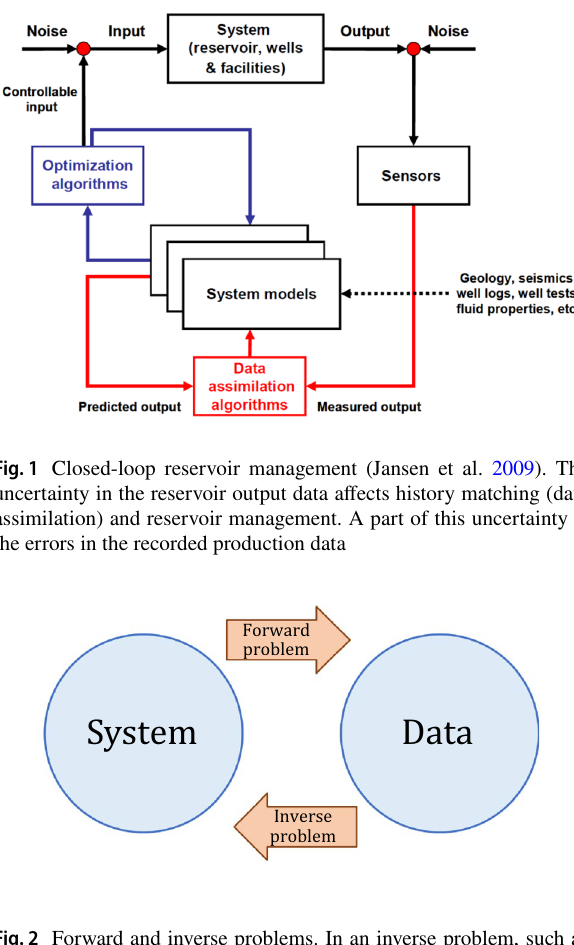
Fig. 2 Forward and inverse problems. In an inverse problem, such as history matching, the characteristics of an unknown system are esti- mated based on its observed output